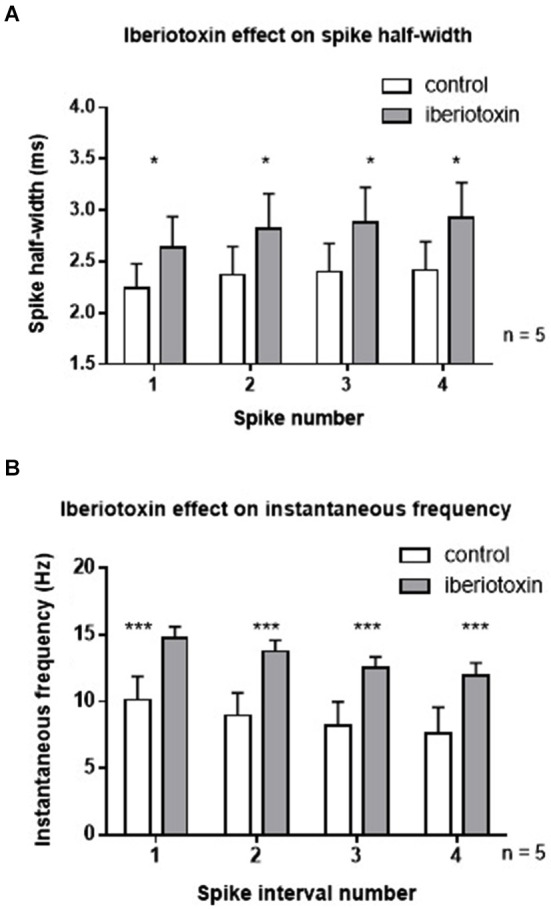
Iberiotoxin (100 nM) mimicked the effects of paxilline on spiking activity. (A) Iberiotoxin (gray bars) significantly affected the spike half-width across the first four spikes (*p < 0.05) compared to control (white bars). (B) Iberiotoxin application significantly increased instantaneous frequency (***p < 0.001). Data are reported as mean ± SEM.